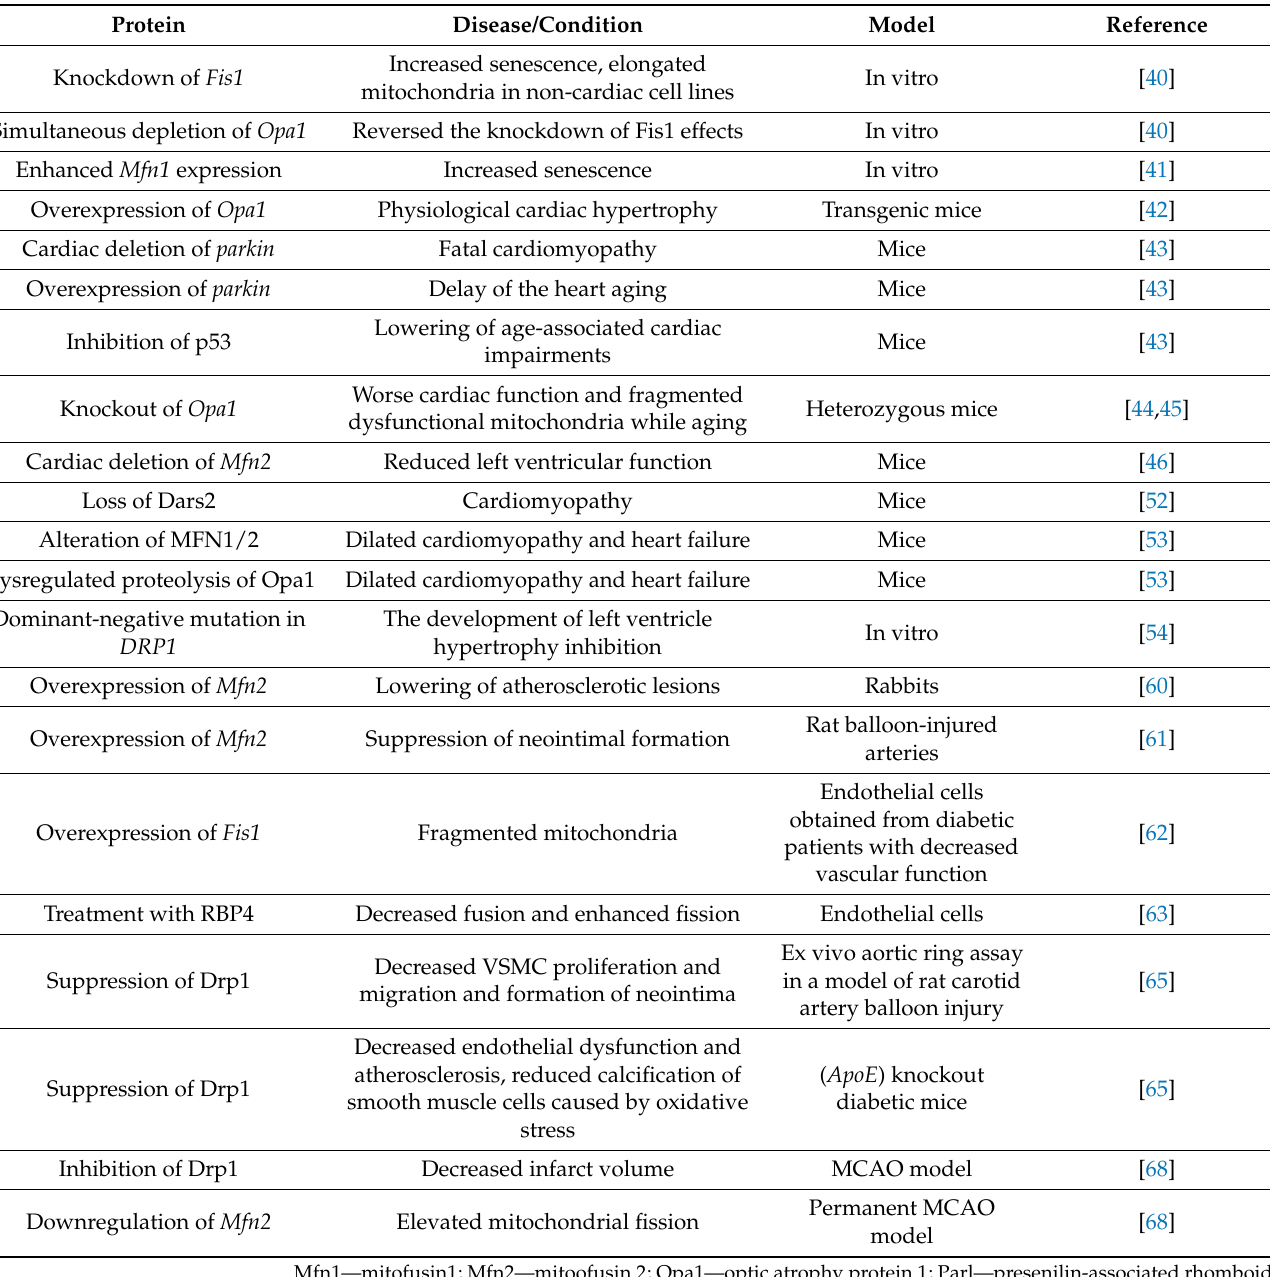
Table 2. Summary of proteins associated with mitochondrial dynamic effects on various cardiac